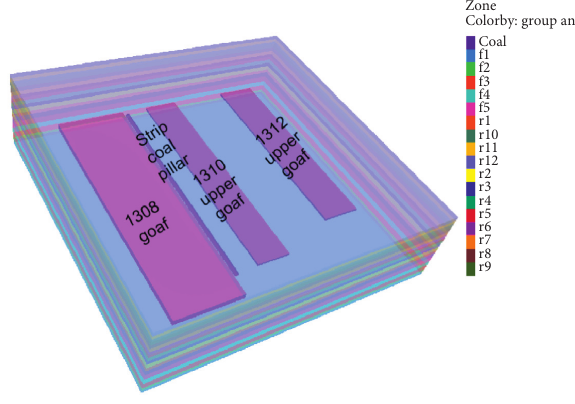
Figure 13: Numerical